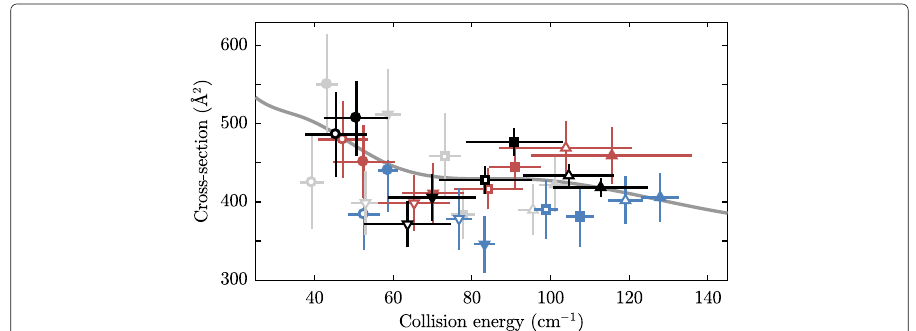
Fig. 16 Total, integrated, ND 3 + Ar collision cross section versus collision energy. The meaning of the black, grey, red, and blue points is described in the main text. The vertical error bars denote standard errors, the horizontal error bars denote the collision energy distributions as depicted in Figs. 14 and 15. The grey line shows the result of scattering calculations[43], convoluted with a normal distribution with a standard deviation of 5 cm − 1 . The measurements are collectively fit to this calculation with a single global scaling factor that represents the density of the argon beam at T = − 150 °C, which is found to be 7.8 × 10 9 cm − 3 . = 1.3. Reprinted with permission from Ref. [32] ©2018 χ 2 red, ν = 31